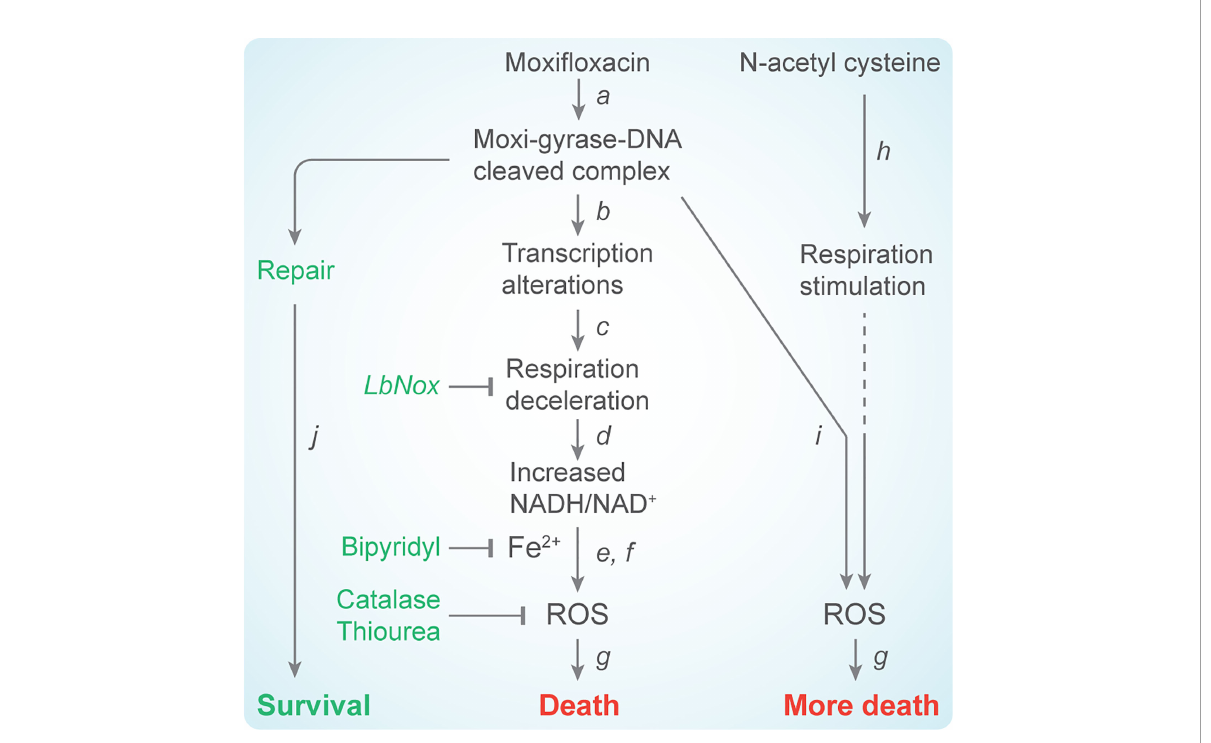
FIGURE 2 Scheme describing moxi fl oxacin-mediated killing of M. tuberculosis enhanced by NAC. ( a ) Moxi fl oxacin enters M. tuberculosis and traps gyrase on DNA as bacteriostatic drug-enzyme-DNA complexes in which the DNA is broken. This step is reversible. ( b ) The bacterium responds by down-regulating expression of genes involved in respiration. ( c ) The transcriptional changes result in reduced rate of respiration. ( d ) NADH levels and the ratio of NADH to NAD + increase; over-expression of LbNox , an NADH oxidase, interferes with downstream events. ( e ) NADH increases the free Fe 2+ pool by releasing Fe from ferritin-bound forms and keeps it in a reduced state. Bipyridyl, an Fe chelator, blocks downstream events. ( f ) Elevated Fe 2+ promotes the Fenton reaction and production of hydroxyl radical. Thiourea, a radical scavenger, blocks downstream events. ( g ) ROS damage macromolecules and cause death in a self-amplifying process, as indicated by exogenous catalase blocking the killing when added after removal of moxi fl oxacin. ( h ) Addition of N-acetyl cysteine to cells stimulates respiration and ( i ) provides more ROS from moxi fl oxacin-mediated lesions. NAC alone does not induce ROS or trigger death. The additional ROS increase killing by moxi fl oxacin. ( j ) Repair of moxi fl oxacin-mediated lesions, NADH dissipation, Fe sequestration, and ROS detoxi fi cation mechanisms contribute to